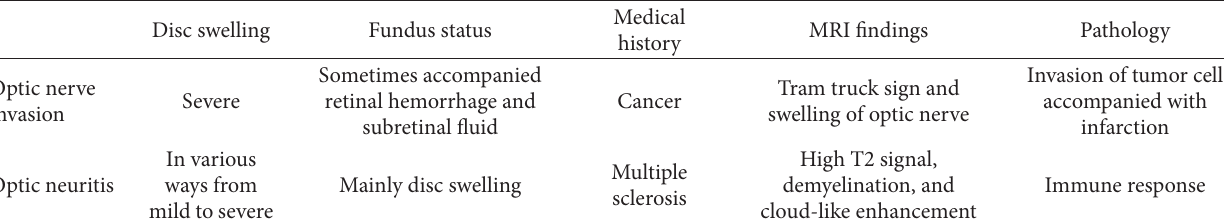
Table 2: Differential diagnosis of optic nerve